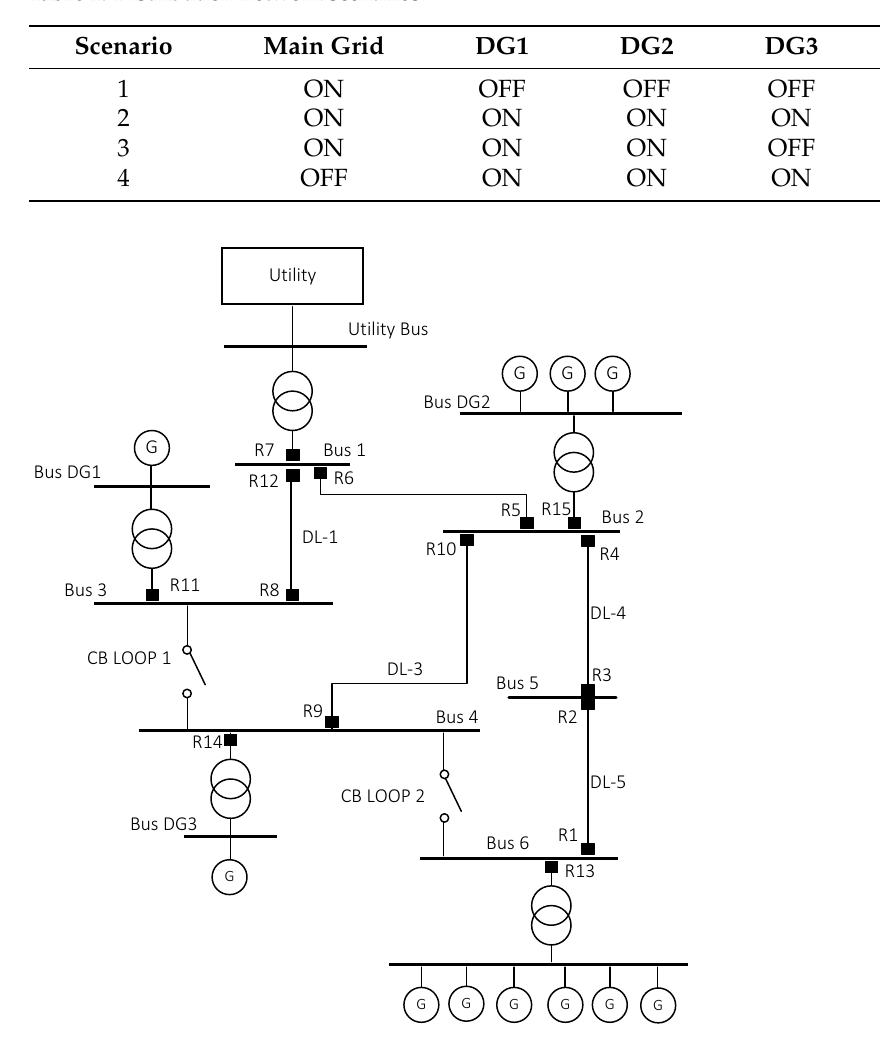
Table 1. Distribution network scenarios.